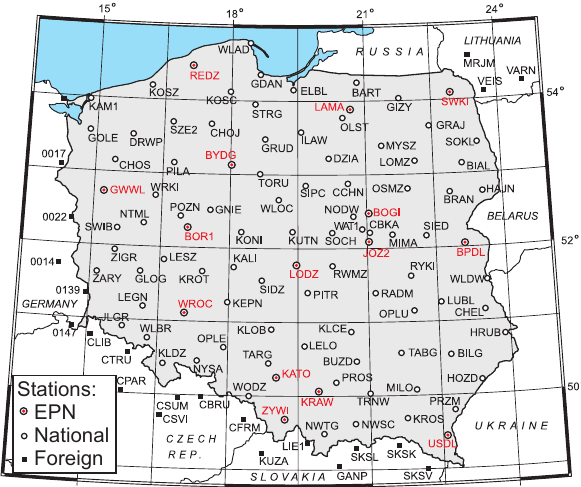
Fig. 1. Reference stations of ASG-EUPOS system (www.asgeupos.pl): 15 EPN, 85 national, 25 foreign (7 Novem- ber